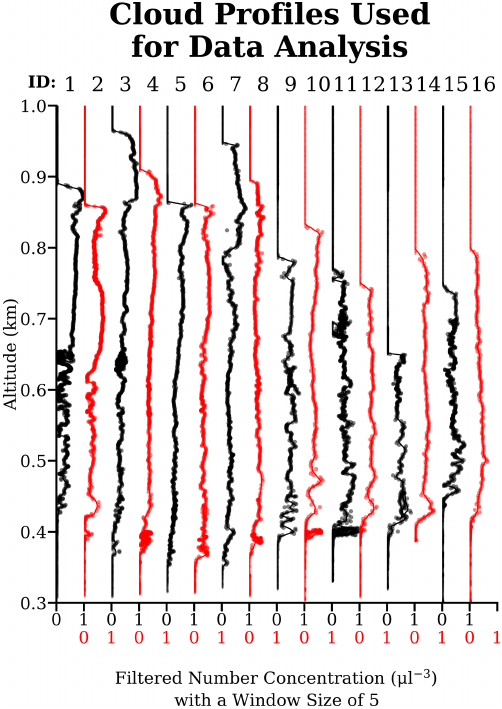
Figure 8. The number concentration profiles through the stratus cloud, shown for the context of the campaign. The profile ID is shown above each panel and is consistent with Table 3. The as- cending profiles are shown in black, and the descending profiles are shown in red.